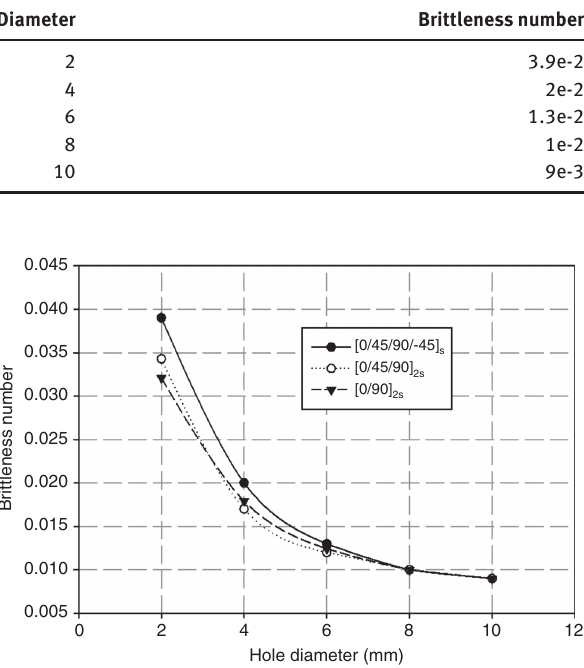
Figure 11 Comparison of different stacking sequences with different specimen